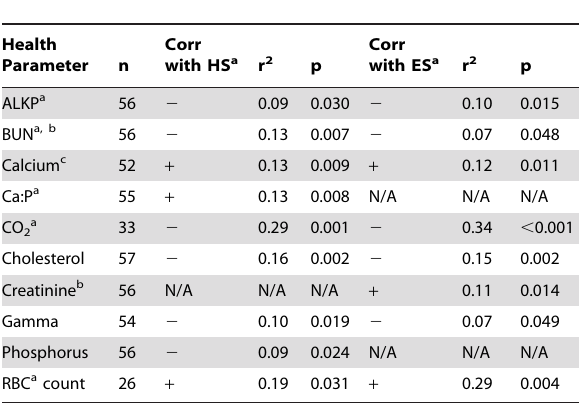
a ALKP=Alkaline phosphatase, BUN=Blood urea nitrogen, Ca:P=Calcium:phosphorus ratio, CO 2 =Carbon dioxide, Corr=Correlation, HS=Hatching success, ES=Emergence success, RBC=Red blood cell. b Using rank regression. c 0% hatching and emergence success nests removed from statistical tests (subsequently